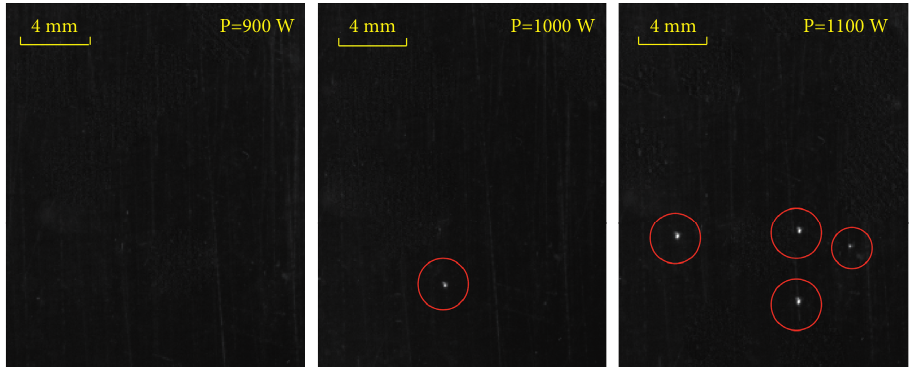
Figure 7: Photos of ONB site in channel b ( T